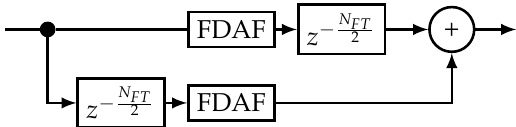
Figure 3. Block diagram for Dual-FDAF. ©IEEE. Reprinted, with permission, from